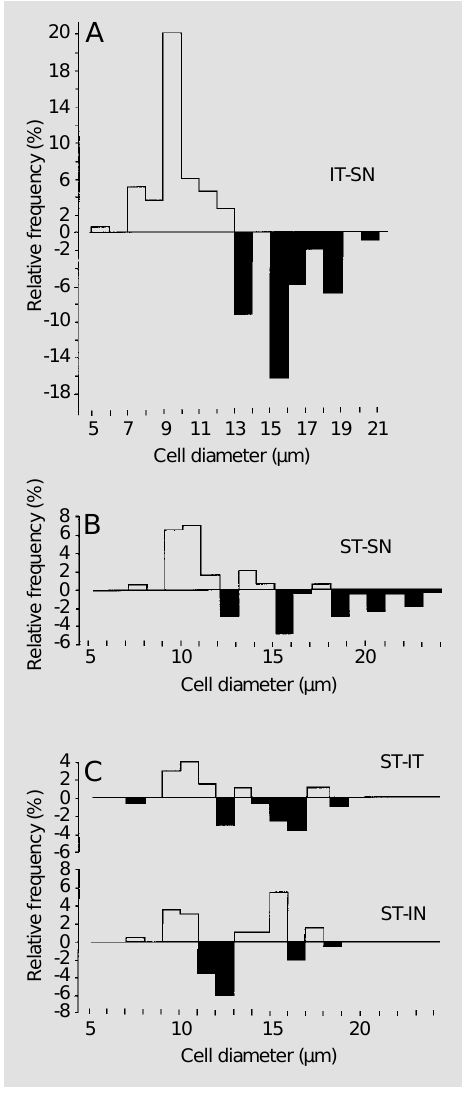
Figure 4 - Distribution of gan- glion cell diameters in two dif- ferent quadrants of the retina in Bradypus variegatus (A) and Choloepus didactylus (B). The relative frequency was obtained by subtracting the number of cells in the inferior temporal retina (IT) of the area centralis in Bradypus variegatus and in the superior temporal retina (ST) of Choloepus didactylus from the regions of lowest cell density in the superior nasal retina (SN) of both species. An excess of cells for each region of the area cen- tralis over the nasal temporal retina is indicated by the portion of the histogram above the 0% line and the excess of cells for each region of the superior na- sal retina over the inferior tem- poral retina is indicated by the portion of the histogram below the 0% line. C is a histogram obtained by subtracting the rela- tive frequency of cell diameters in the region of the area centra- lis (ST) of the retina in Choloe- pus didactylus from those in the IT and inferior nasal (IN) quad-